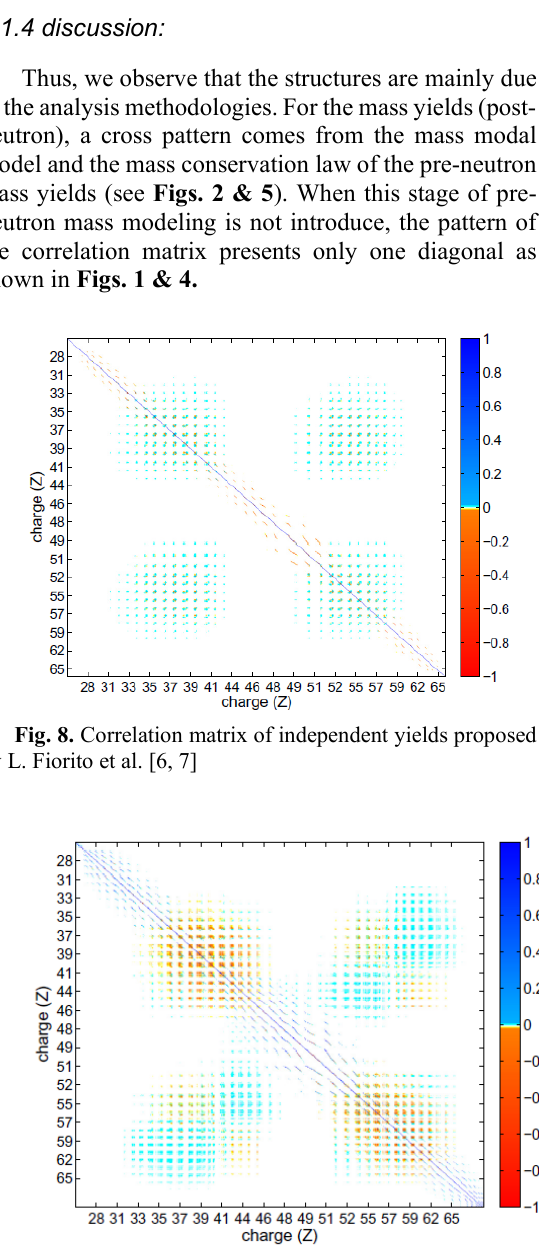
Fig. 5. K.H. Schmidt et al. GEF-2021/1.1 [14]